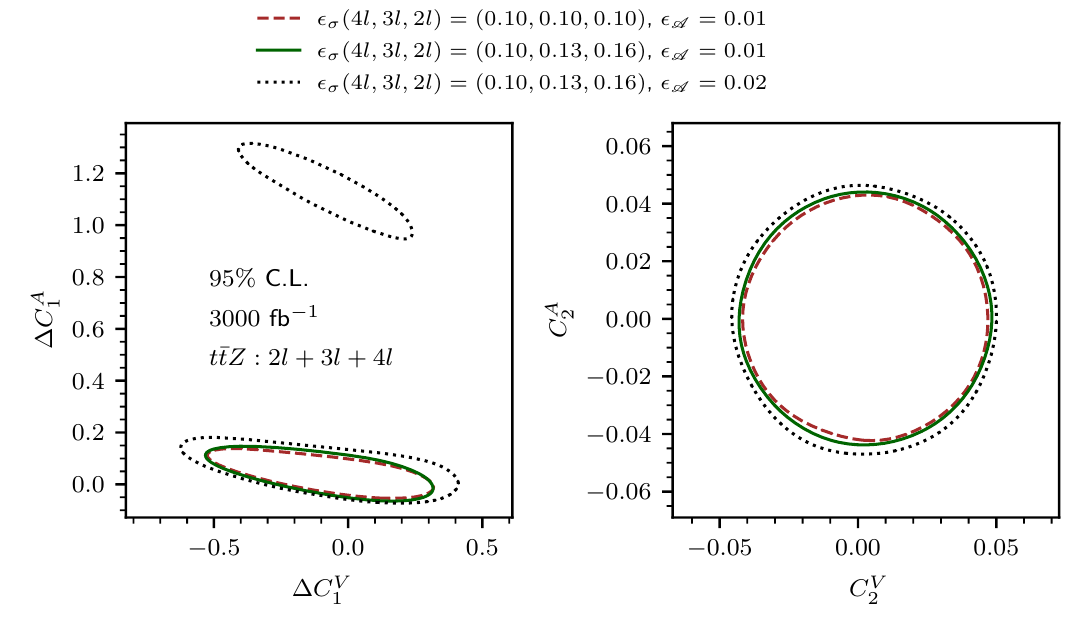
- ∆ C A ( left-panel ) and C V - C A ( right- 1 1 2 2 √ s = 13 TeV